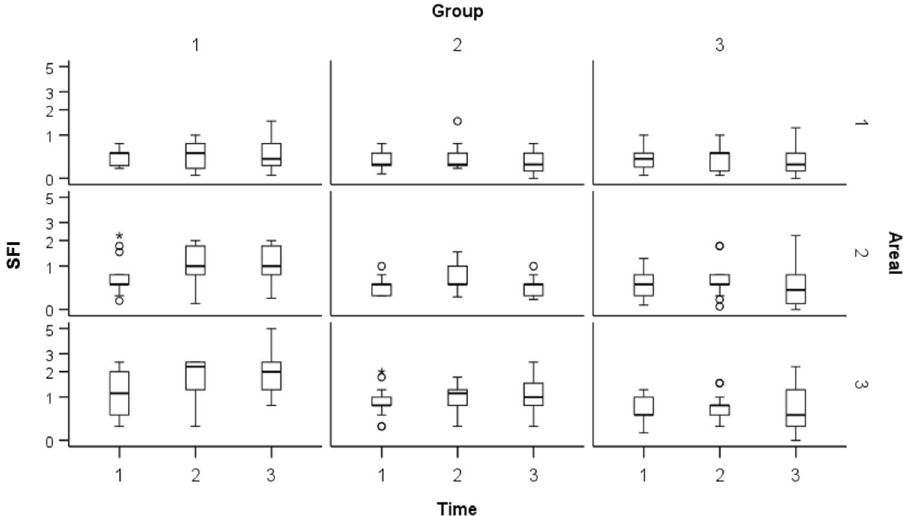
Figure 4. Slope of fluorescence intensity (SFI) values of all groups (1 = control, 2 = nitroglycerine, 3 = volume) are shown in logarithmic form in boxplots at each measurement time (1 = Hypotension, 2 = Normotension, 3 = Hypertension) in each areal (1 = tip, 2 = corpus, 3 = prepyloric). Circles (°) represent mild outliers and asterisks (*) represent extreme outliers. The y-axis shows a logarithmic representation of the SFI values while the other axes represent categorical variables. SFI represents the maximal increase of the time-dependent fluorescence intensity induced by the first wave of the Indocyanine green (ICG), which passes the capillaries of the gastric tissue. SFI-values in groups two and three were significantly lower in areal 2 and 3 compared to the control group (p < 0.001). SFI-values in areal 1 showed no significant differences between all groups. In group 3, hypertension resulted in decreasing SFI indicating impaired